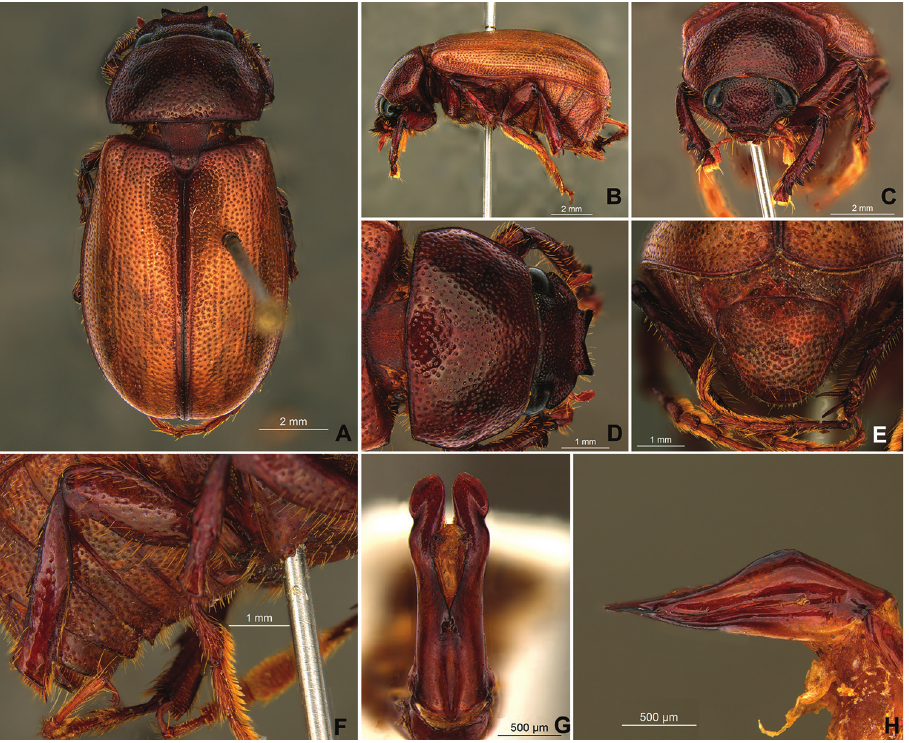
Figure 86. Liogenys pseudospiniventris Cherman, sp. n. A Dorsal view B Lateral view C Frontal view D Clypeus and pronotum E Pygidium F Abdomen, lateral view G Parameres, dorsal view H Parameres, lateral